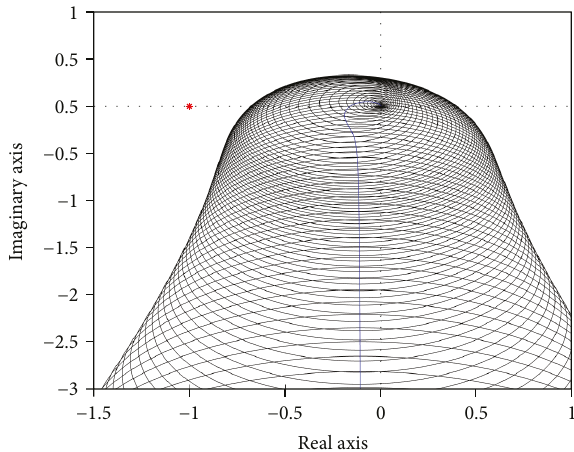
Figure 10: Envelope of Nyquist diagrams for FO plant family (29) and controller (22).